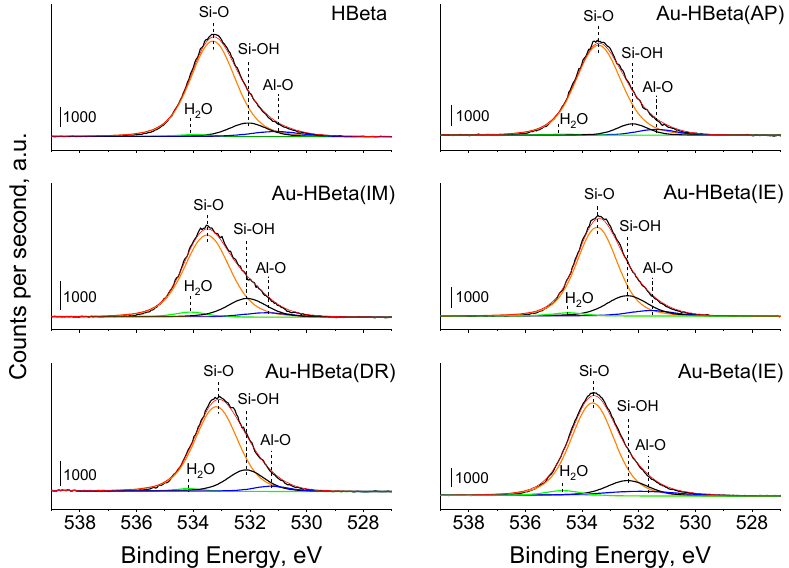
Figure 5. O 1s XP spectra of HBeta and gold-modified zeolites.